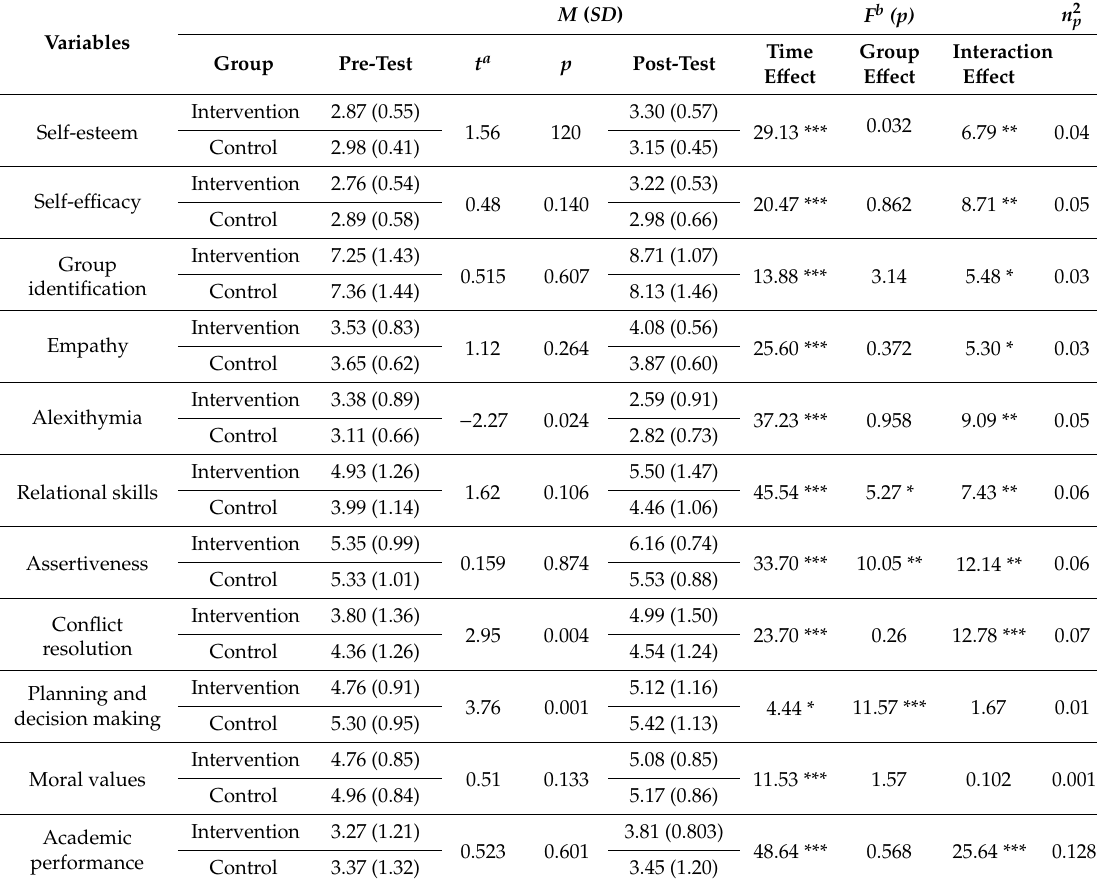
Table 4. Descriptive statistics and repeated-measures ANOVA for PYD